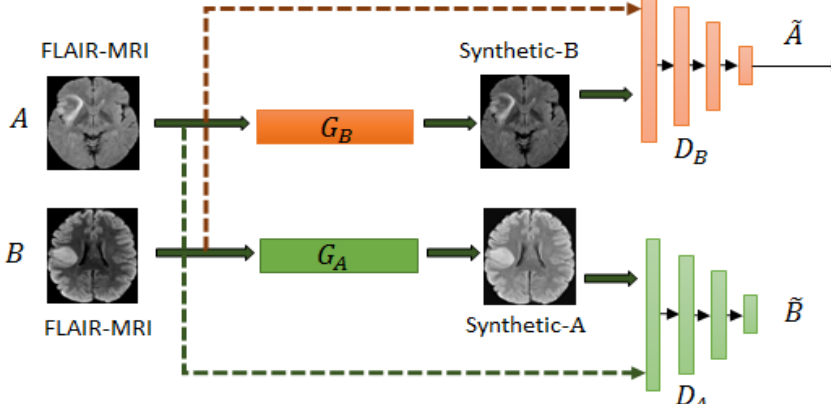
Figure 2. Example of unpaired Cycle Generative Adversarial Network (CycleGAN) used for mapping images from domain A to domain B for FLAIR-MRIs. The generators are G A and G B and the discriminators are D A and D B .